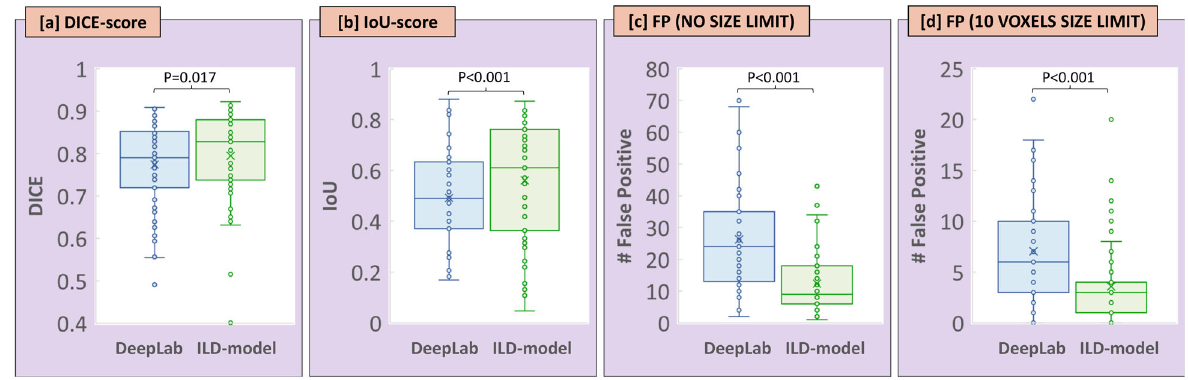
Fig. 3 Segmentation performance. Segmentation performance Boxplot showing the resulting ( a) Dice-score and ( b) IoU-score, as well as the number of false positive ( c) without and ( d) with a lesion-size limit of 10 mm 3 , as determined from the segmentation probability maps produced by the DeepLab V3 model (blue) and the in-house ILD-method (green). Boxplots illustrate median (center line) and mean (X inside box) values, interquartile range (bounds of box), minimum and maximum values (whiskers), and outliers (circles outside whiskers).